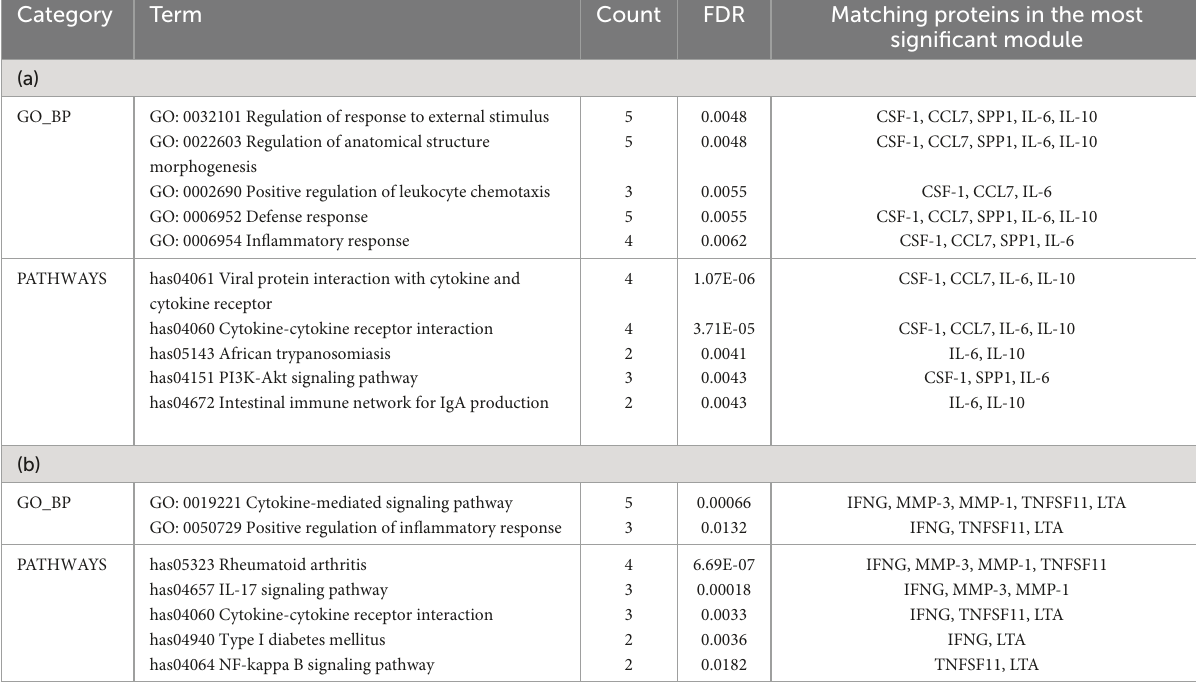
TABLE 5 GO_BP and KEGG pathways enriched in the most significant module in the RF group (only top five listed). Category Term Count FDR Matching proteins in the most